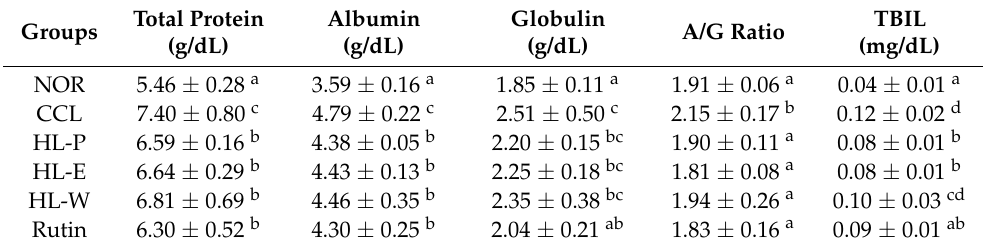
Table 4. The effects of red quinoa and its extracts on serum total protein, albumin, globulin, A/G ratio and total bilirubin of the CCl 4 -induced liver injury